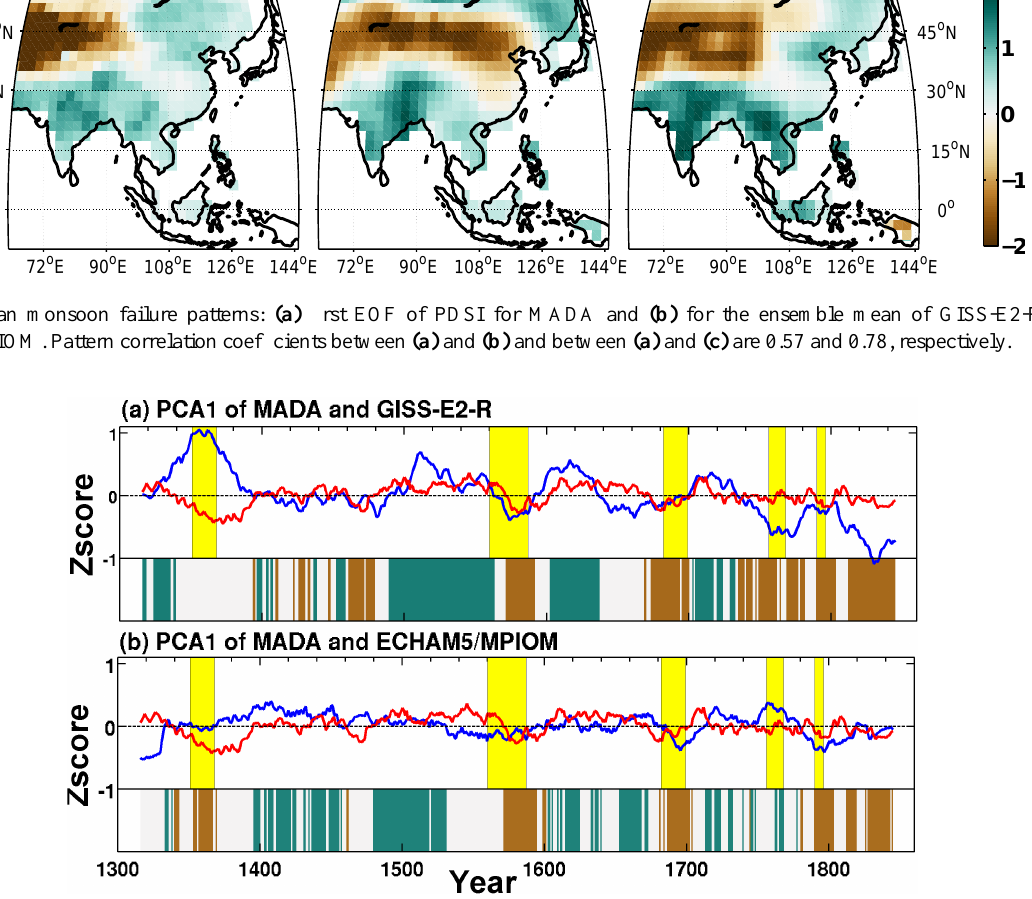
Figure 2. Time expansions of monsoon failure patterns for (a) MADA (red) and the ensemble mean of GISS-E2-R (blue), and (b) MADA (red) and the ensemble mean of ECHAM5/MPIOM (blue). Time series have unit variance and zero mean and are smoothed using a 31-year moving average filter. Green (brown) shadings indicate the times when both time series are greater (smaller) than zero. Five historically recorded mega-drought periods are shaded in